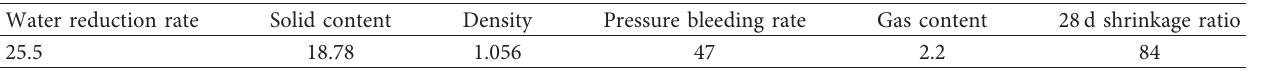
Table 2: The main technical index of water reducer (%).